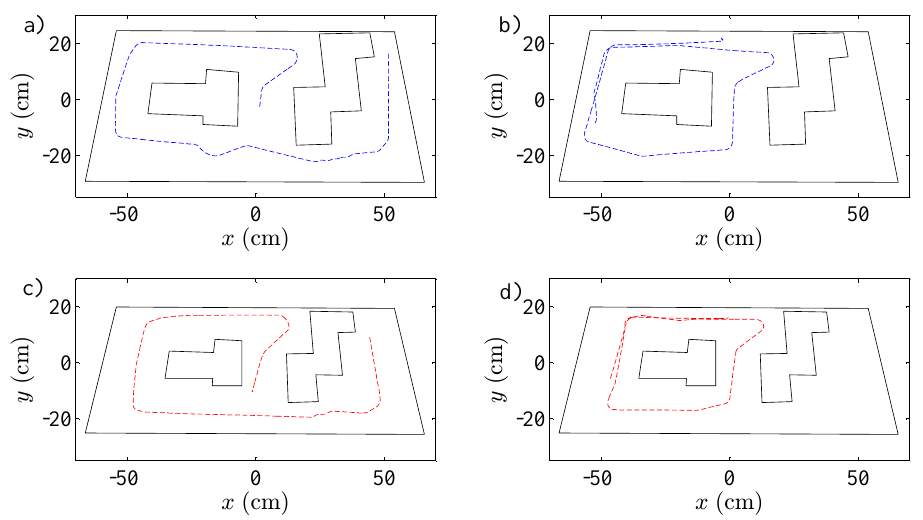
Figure 17. Trajectories of the robots controlled by the obstacle avoidance algorithm. The blue dashed line represents the discrete-time solution. ( a ) Robot 1; ( b ) Robot 2. The red dashed line is the event-based strategy. ( c ) Robot 1; ( d ) Robot 2.